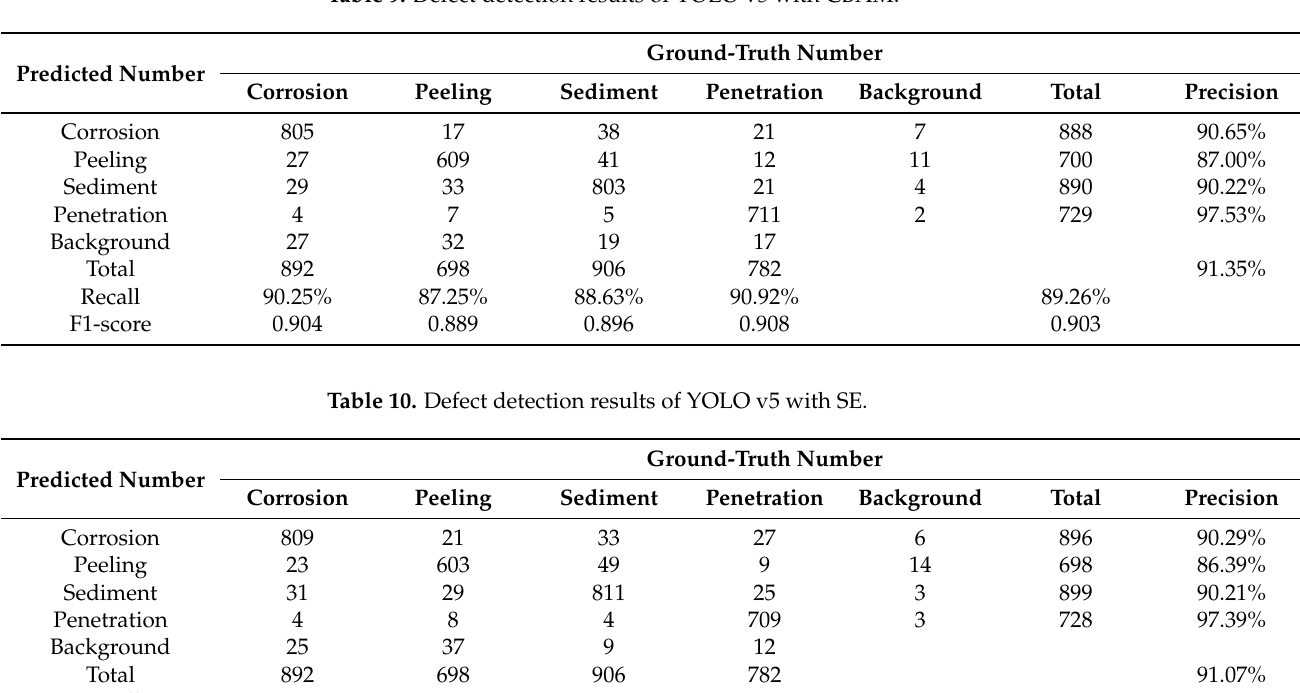
Table 9. Defect detection results of YOLO v5 with CBAM.